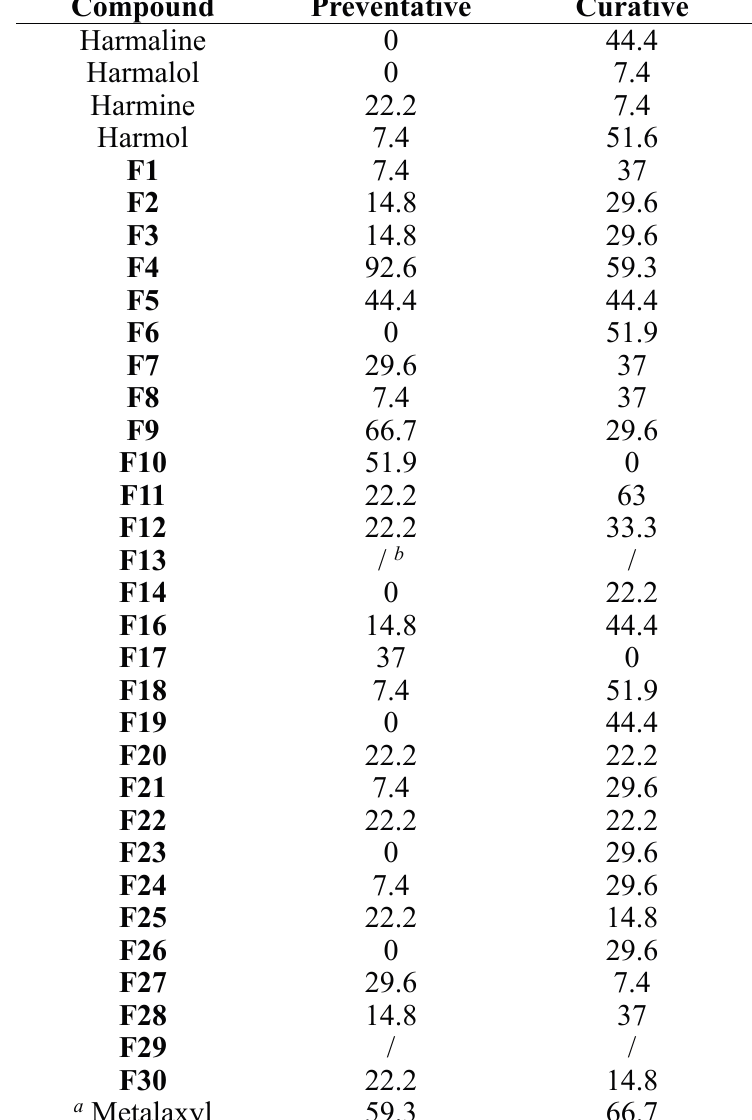
Table 2. Fungicidal activities of compounds F1 – 30 against P. litchi by litchi leaf-piece assays (percent inhibition, %; 100